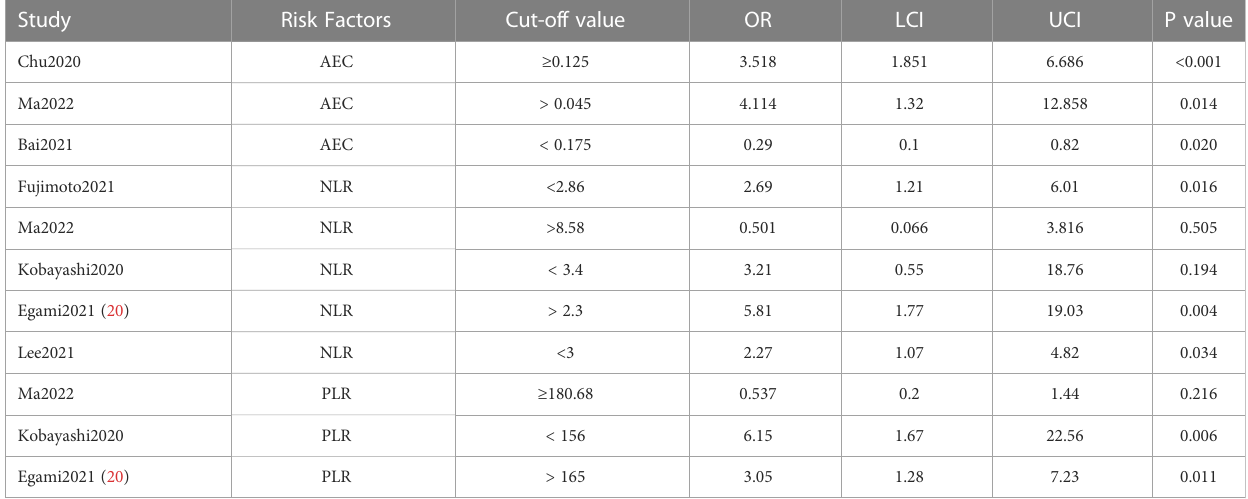
Table of cut-off values.